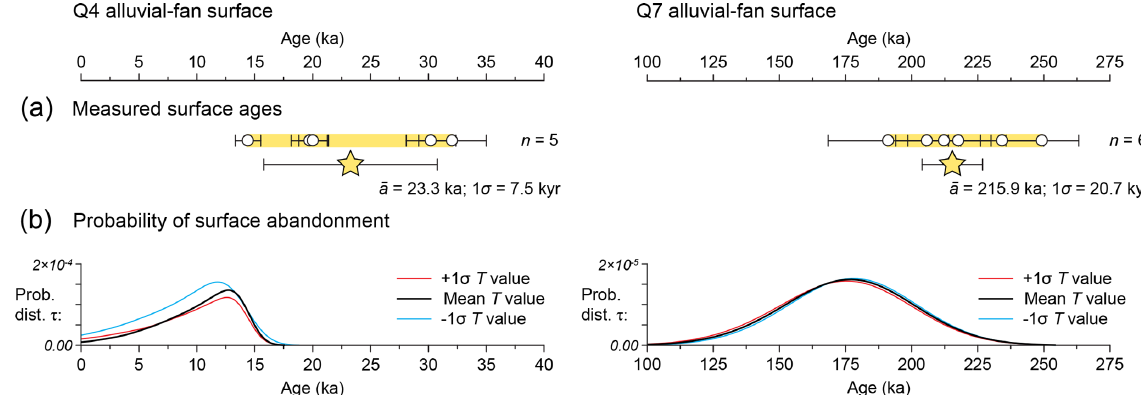
Figure 9. (a) Measured surface ages for the Laguna Salada alluvial-fan surfaces, following Fig. 8b. (b) Probability distributions of τ calcu- lated using Eq. (2) and incorporating age uncertainty, where T is derived from the measured spread of surface ages using the mean case in Fig. 6 (black curves) and ± 1 σ uncertainties in T (red and blue curves).